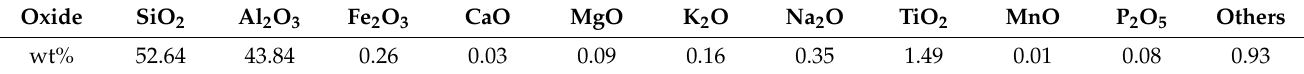
Table 2. The bulk chemical composition of metakaolin in this study. XRD analysis proved that the TiO 2 content originated from anatase.